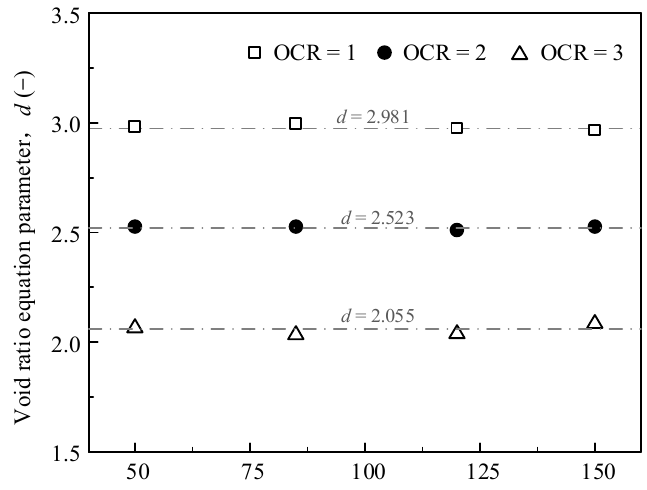
Figure 5. Relationship between d and σ 3c ’ with different OCR.